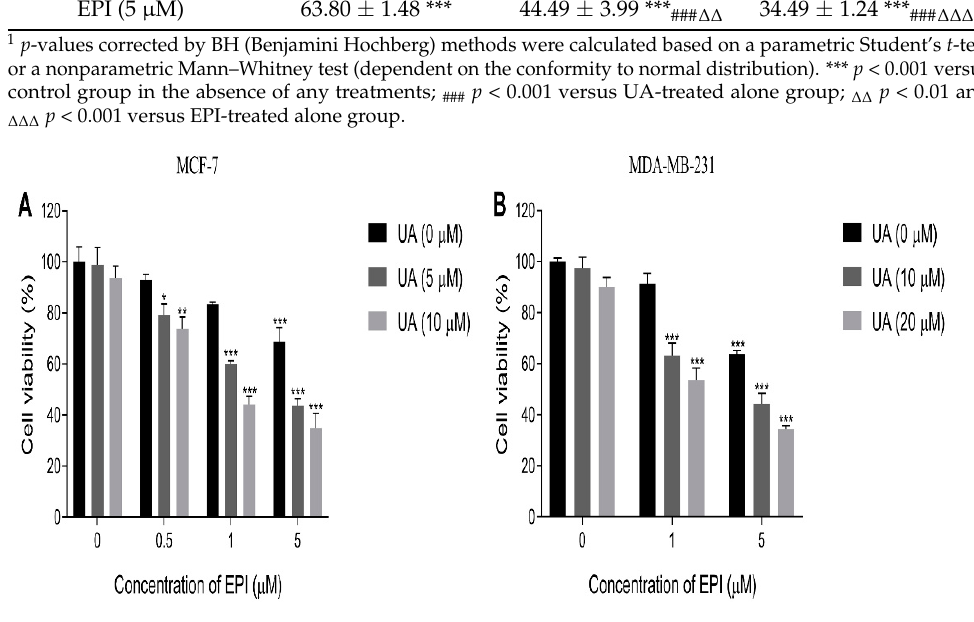
Student’s t -test or a nonparametric Mann–Whitney test (dependent on the conformity to normal